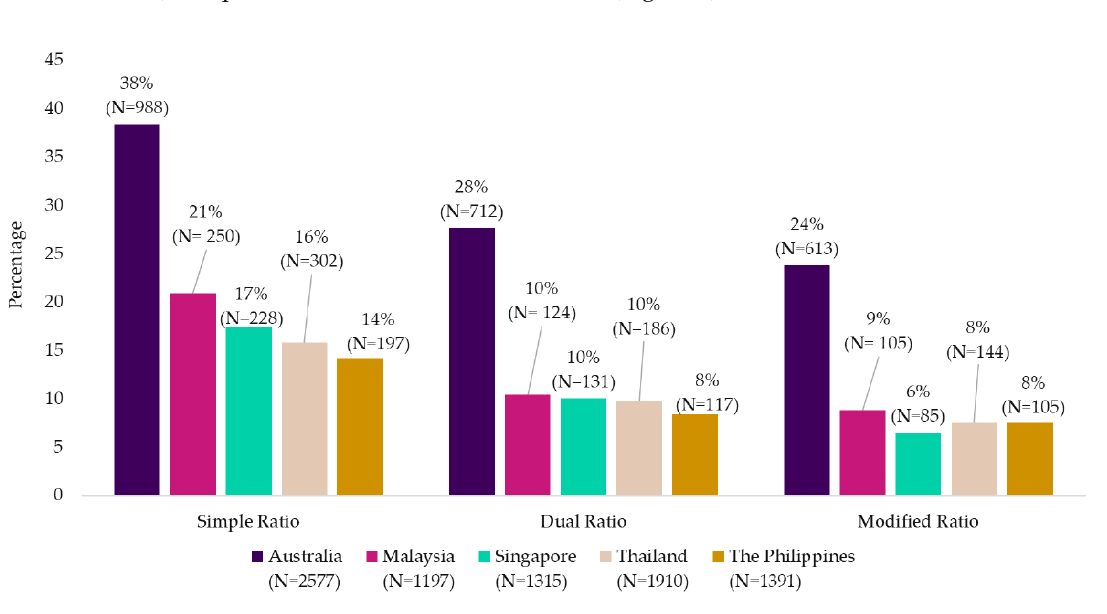
Table 2. Comparison of mean nutrient composition of carbohydrate-based packaged food sub- categories from AFCD-1 that passed or failed all of the three carbohydrate metrics. Mean Nutrient Unit p Value Pass Fail Percentage of sub-categories ( n = 86)